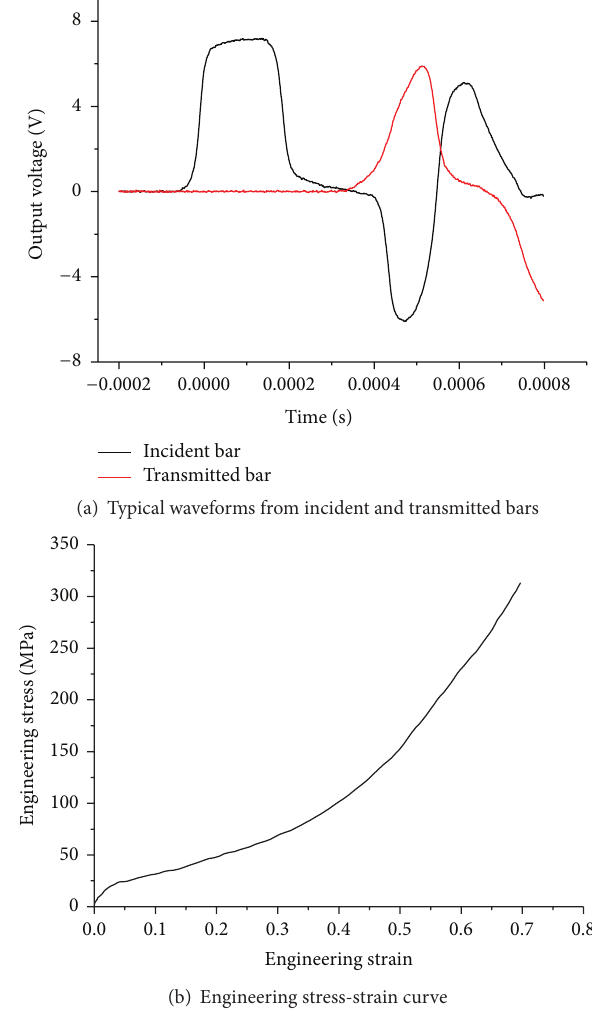
8HRB335 single limb stirrup ( 𝑍 direction) is arranged at the distance of 180